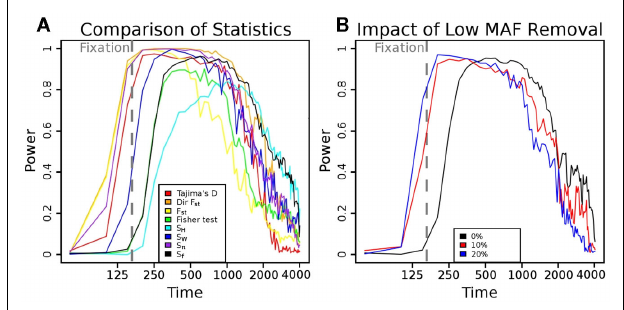
FIGURE 1 | Power of different statistics as a function of time since bottleneck. (A) Power versus time plots for multiple statistics given a fixed selection pressure ( s = 0.08). Statistics that weigh low frequency SNPs more, such as S W , have a higher peak power, but decay faster. On the other hand, statistics that weigh high-frequency SNPs more, such as S H , have a lower peak power, but retain power for a longer timespan. S f (black, equal weights) and directional F st (orange) both provide a reasonable compromise between peak power and duration. (B) The influence of removing low minor allelic frequency SNPs on the power of the S f statistic.The black line represents the power of the S f statistic at s = 0.08.Through tossing out low frequency SNPs (MAF < 10%, red curve and < 20%, blue curve), we have a buffer from moderate error rates. As we weigh intermediate frequency SNP counts more, we have a slight gain of peak power, and this power is gained prior to fixation (as the extremely high-frequency SNPs are tossed out). However, the counts are lower and thus, more susceptible to noise, so we lose power over longer time spans.The red curve (10%) seems to provide a reasonable compromise between time and duration of high